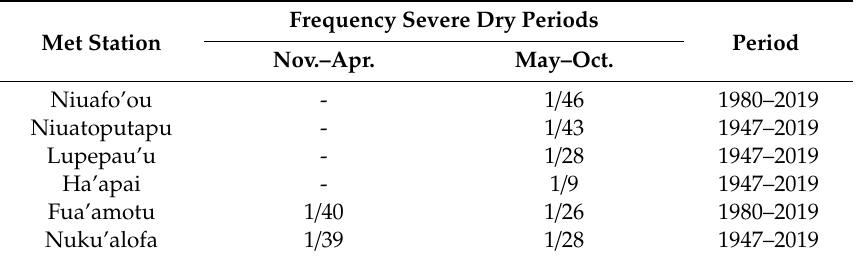
Table 6. Frequency of severe dry periods in both wet and dry season at meteorological stations in Tonga. Frequency Severe Dry Periods Met Station